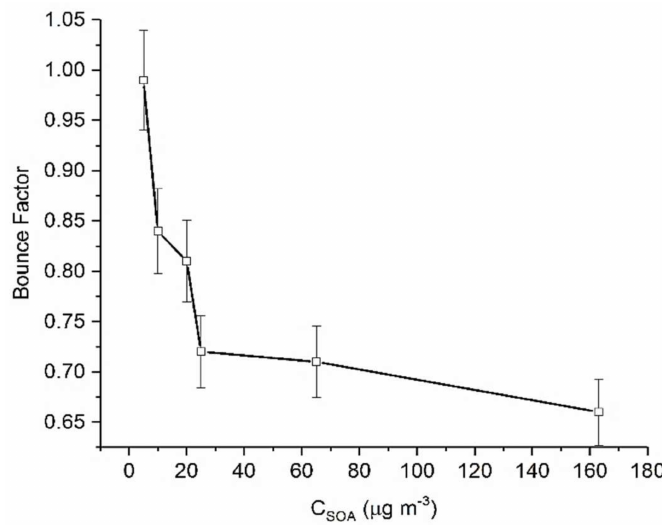
Figure 3. Calculated maximum BF for limonene derived SOA as a function of C SOA . Error bars represent 1 standard